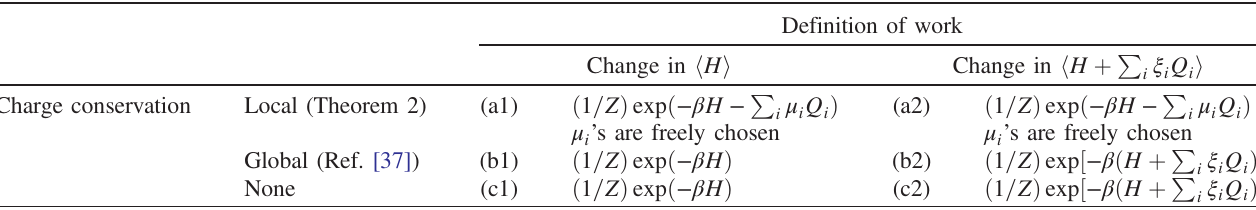
TABLE I. The classes of completely passive states classified by charge conservation constraints and the definitions of work. In the left- hand column, the total energy H tot is conserved, while in the right-hand column, a linear combination H tot þ energy and the total charges is conserved. In Theorem 2, the charges are locally conserved in the system of interest, leading to the form of GGE shown in (a1). In Ref. [37], the charges are globally conserved in the total system including the storage, leading to the form of GGE shown in (b2). Note that the class of operations is strictly smaller than that in the lower row. In particular, the classes of states shown in (a1) and (a2) are strictly smaller than those in (b1) and (b2), respectively. We can obtain the result for (c2) by changing the definition of P ξ Q the Hamiltonian H to H þ in i i i